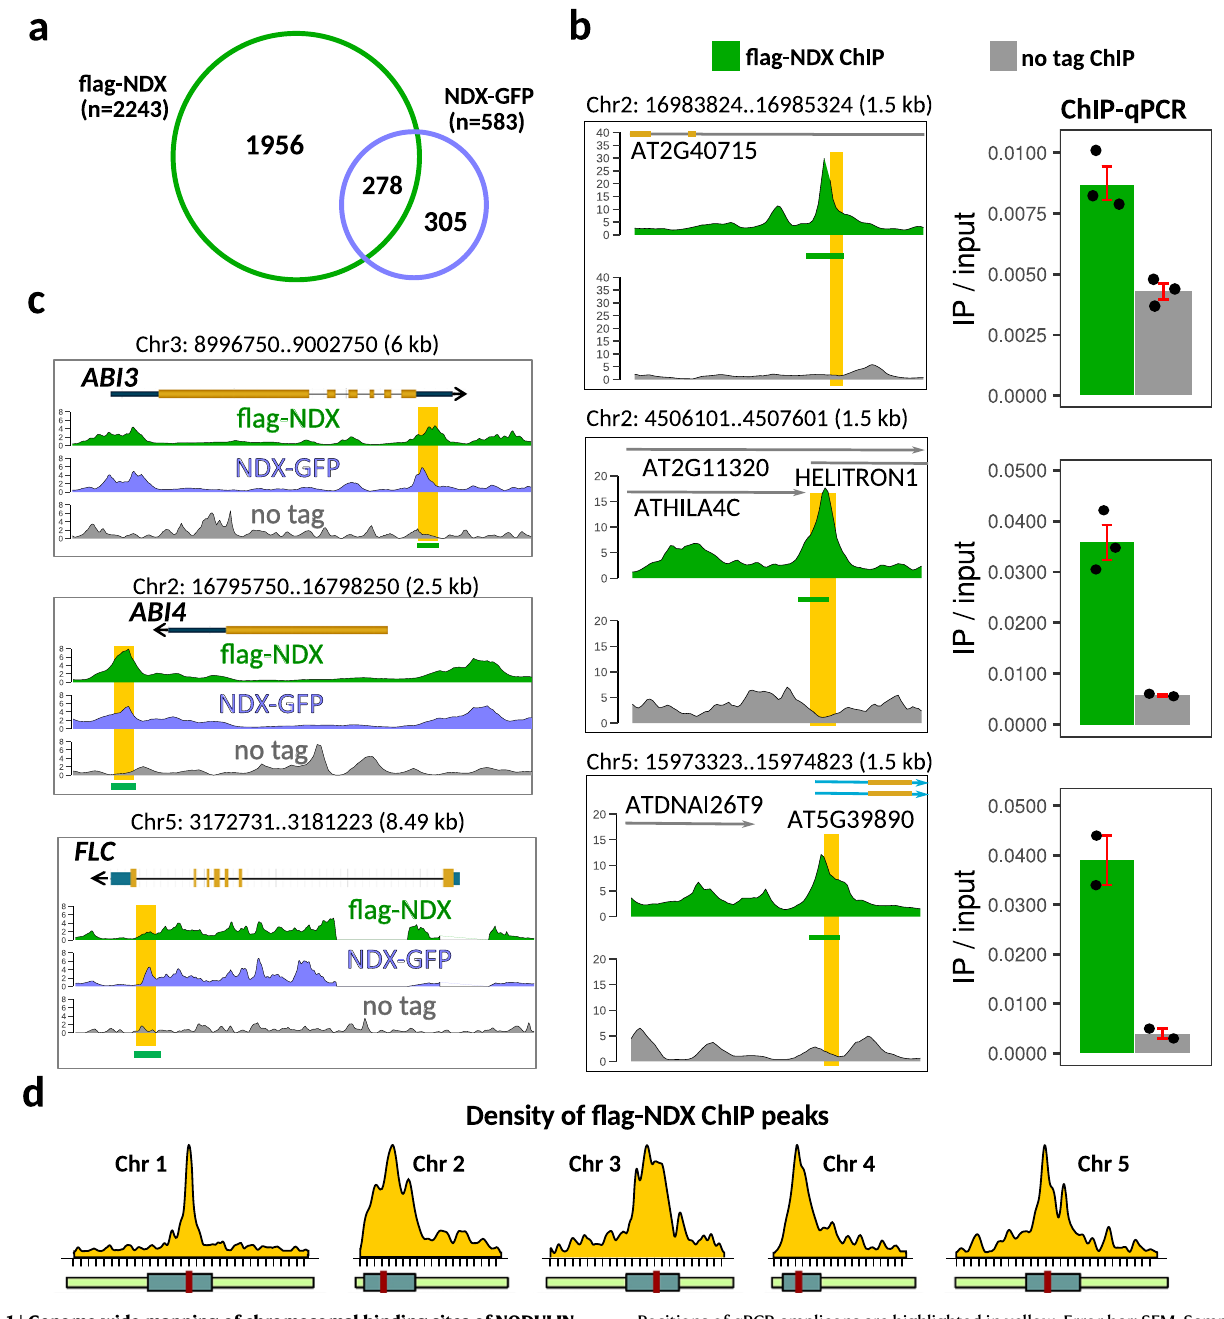
Fig. 1 | Genome-wide mapping of chromosomal binding sites of NODULIN HOMEOBOX (NDX). a Overlap of ChIP-seq peaks identi fi ed in N-terminally and C-terminally tagged fl ag-NDX and NDX-GFP lines, respectively. The proportion of common peaks is signi fi cantly higher thanexpected from a computer randomized distribution (*** p <0.0001, prop.test, two-sided; Bonferroni correction). b ChIP- qPCR validation of representative fl ag-NDX binding sites from different chromo- somes. Genomic positions are indicated on the top of each panel. Speci fi c ChIP signal and background signal ( “ no tag ” ) is shown in green and black,